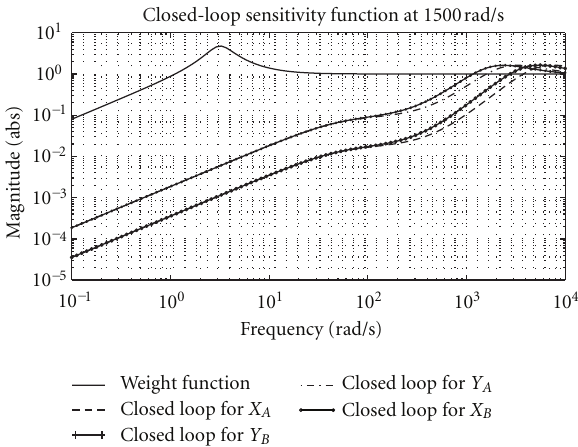
Figure 4: Sensitivity function describing how the disturbance a ff ects the displacement with LSDP controller.